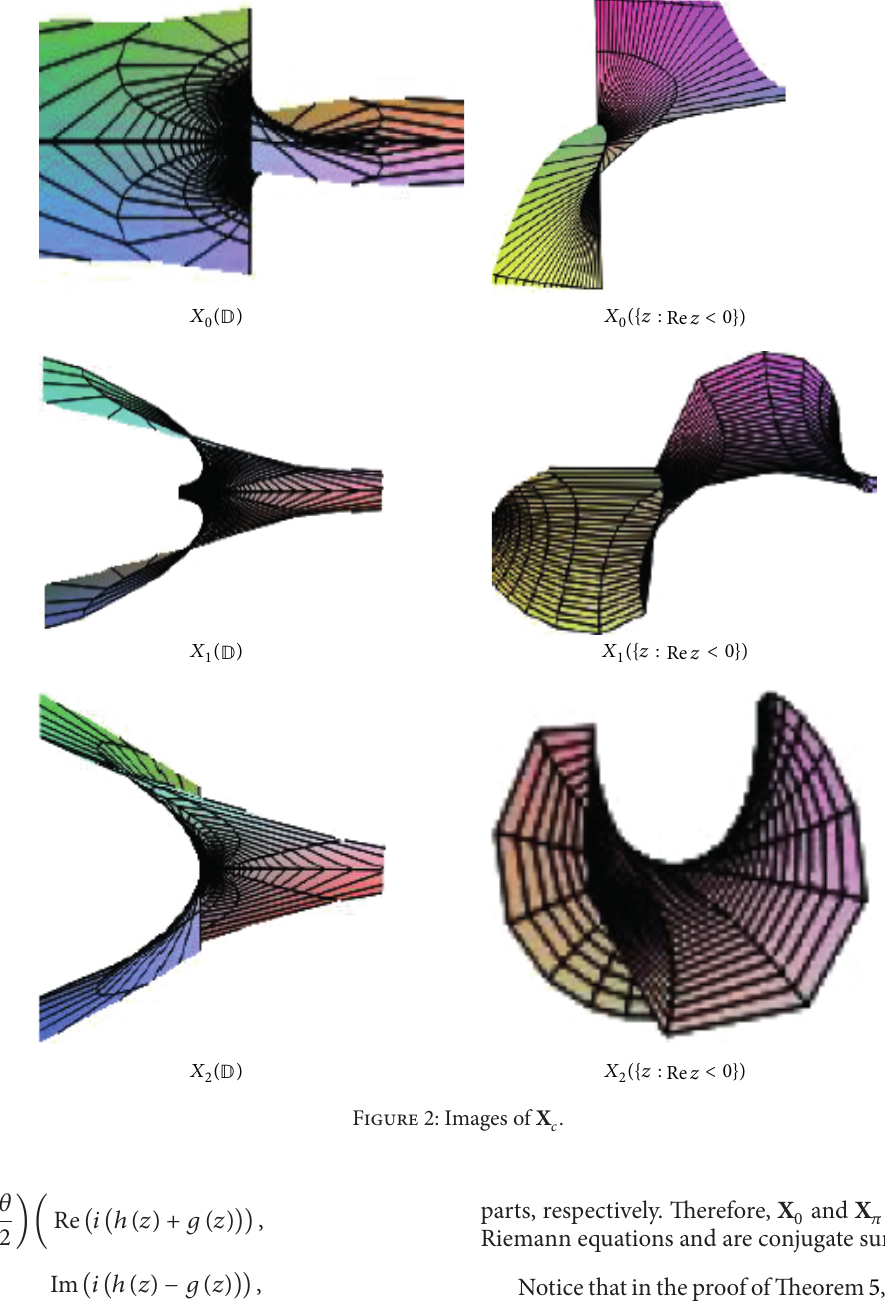
Figure 2: Images of X 𝑐